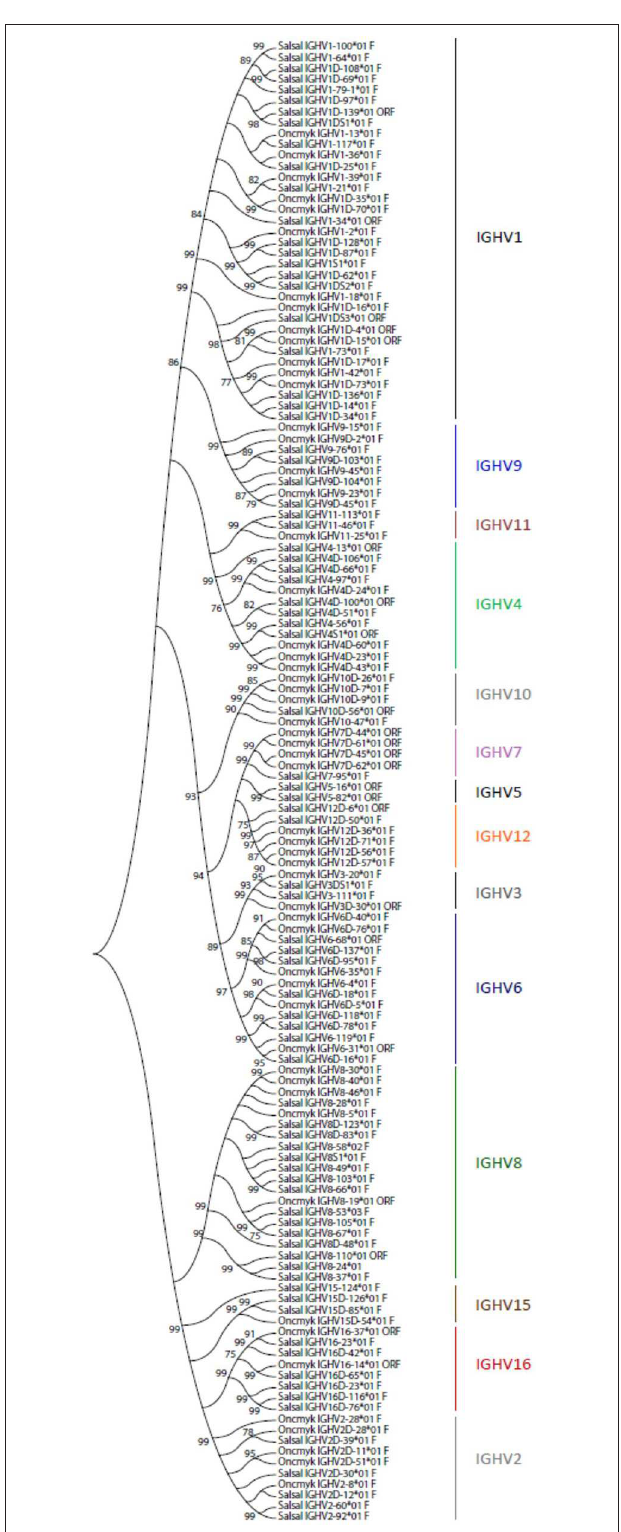
FIGURE 3 | Phylogenetic analysis of Atlantic salmon and rainbow trout IGHV gene sequences. A phylogenetic analysis of the V-REGION of Atlantic salmon (Salsal) and rainbow trout (Oncmyk) IGHV genes (F + ORF) was performed using the UPGMA method and a bootstrap based on 1,000 replicates. A total